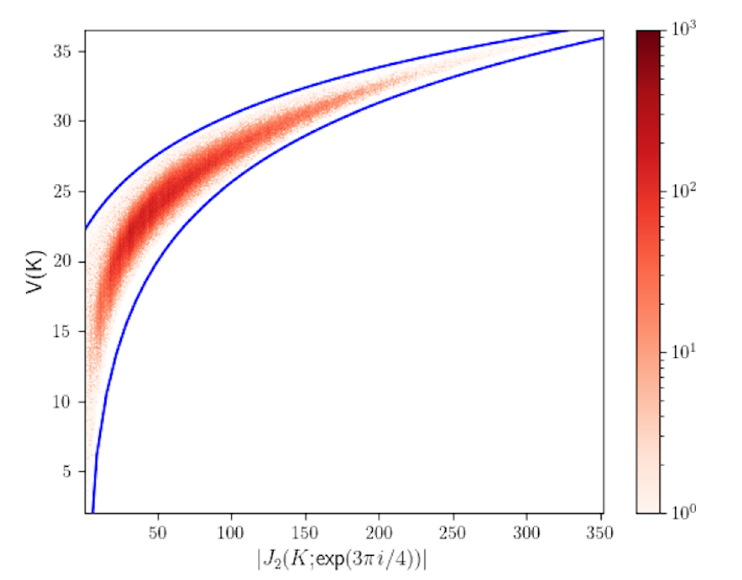
Figure 8 . Bounding curves for the hyperbolic volumes up to and including 16